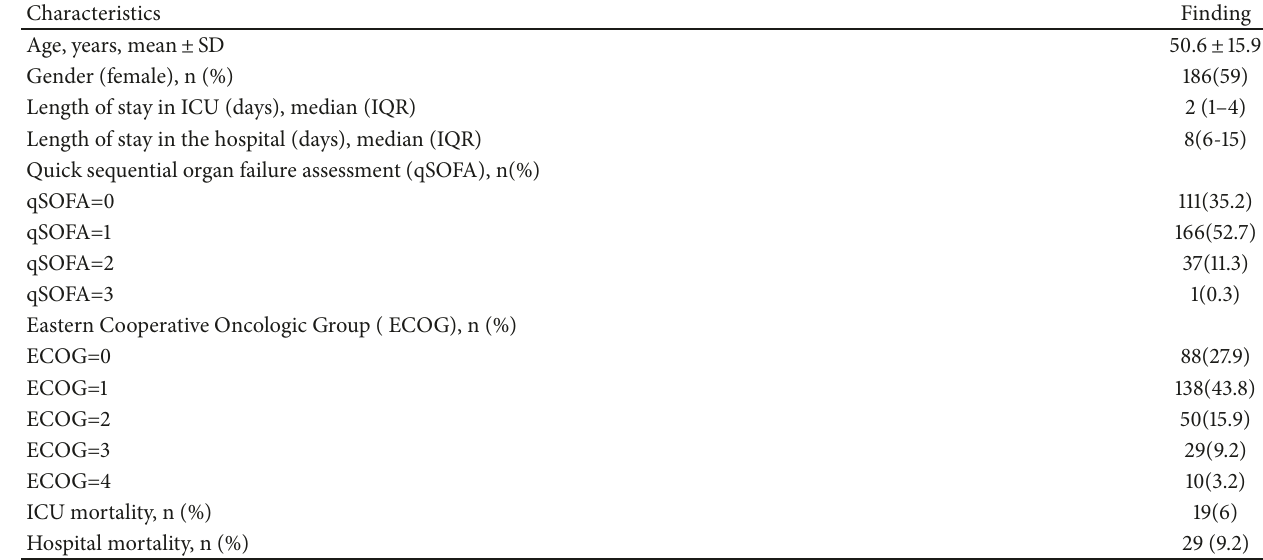
Table 1: Clinical characteristics of critically ill patients without infection who were admitted to the ICU during the postoperative period (n= 315).